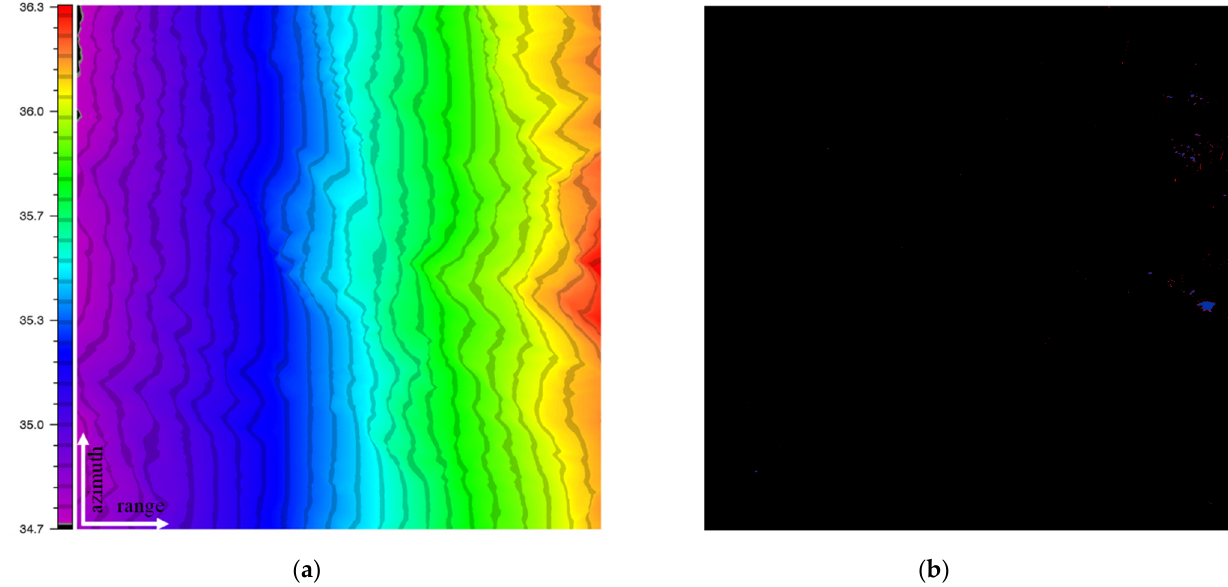
Figure 8. The range direction is from left to right; the azimuth direction is from bottom to top: ( a ) Look Angle Function (LAF) (degree): 𝜃 = 𝜃(𝑟, 𝑎) ; ( b ) a mask identifying (red) layover and (blue) shadow areas.